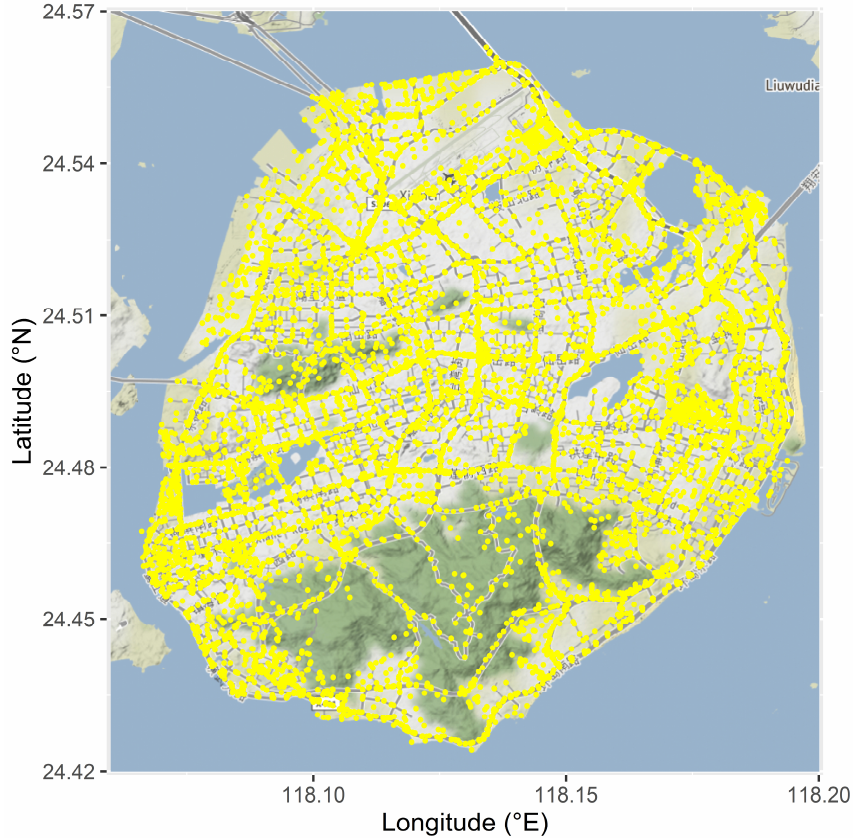
Figure 3. The distribution of collected sampling points in Xiamen Island.